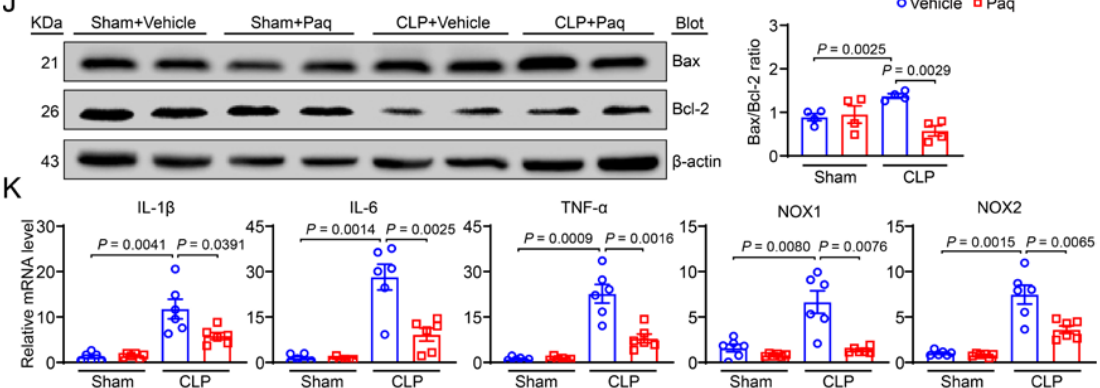
Figure 6. Administration of S100A9 inhibitor Paquinimod suppresses CLP-induced liver dysfunction, damage, apoptosis, inflammation and superoxide production. ( A ) Diagram of S100A9 inhibitor Paquinimod (Paq). ( B ) Schematic diagram of wild-type (WT) treated with S100A9 inhibitor (Paq) and CLP operation for 24 h. ( C ) The levels of serum ALT and AST in each group treated with Paq at dosages of 5, 10 and 20 mg/kg ( n = 6). ( D ) The S100A9 protein level of each group treated with vehicle or Paq at dose of 10 mg/kg. ( E ) Survival rate in vehicle- or Paq-administered mice after 24 h of sham or CLP operation (sham group, n = 5 per group; CLP group, n = 25 per group). ( F ) H&E staining of liver sections (left, CV: central veins), and quantification of the histological score (right, n = 6). ( G ) TUNEL (red) and DAPI (blue) staining of liver sections (left), and quantification of TUNEL + nuclei (right, n = 6). ( H ) Immunohistochemical staining of liver sections with anti-CD68 antibody (left, brown area), and quantification of the CD68 + area (right, n = 6). ( I ) DHE staining of liver sections to measure superoxide production (left) and quantify fluorescence intensity (right, n = 6). ( J ) Immunoblotting analysis of Bax and Bcl-2 protein levels (left), and quantification of Bax to Bcl-2 ratio (right, n = 4). ( K ) qPCR analysis of IL-1 β , IL-6, TNF- α , NOX1 and NOX2 mRNA levels ( n = 6). Data are shown as mean ± SEM, and n represents the number of mice in each